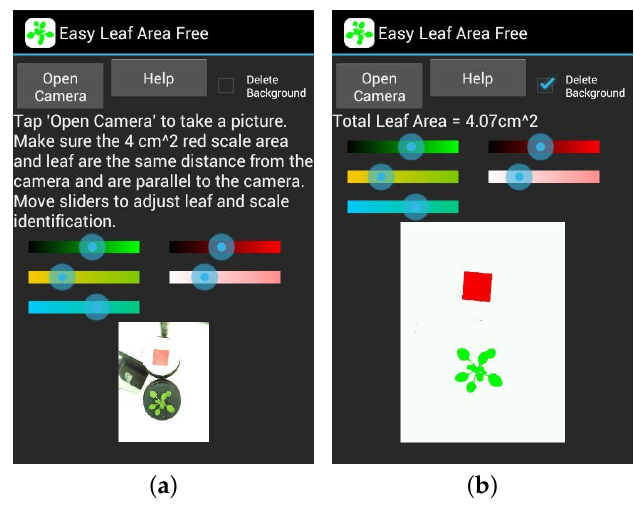
Figure 21. Easy Leaf Area: ( a ) Image capture and slider adjusting; ( b ) Image processing result.